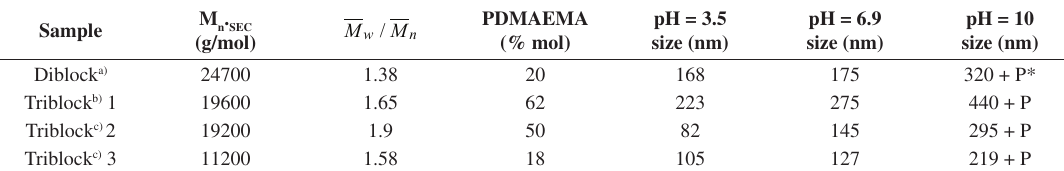
Table 1. Average particle sizes of copolymers at different aqueous solution pH values. Sample